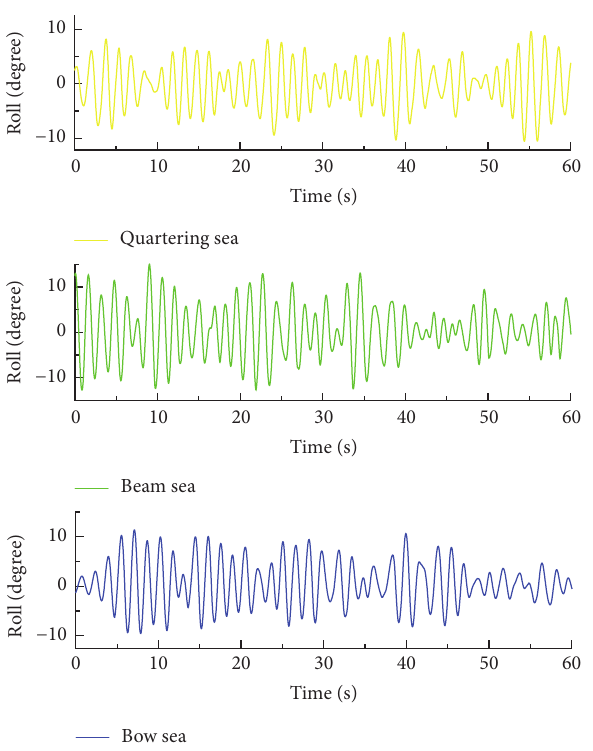
Figure 15: Time histories of roll in irregular waves.